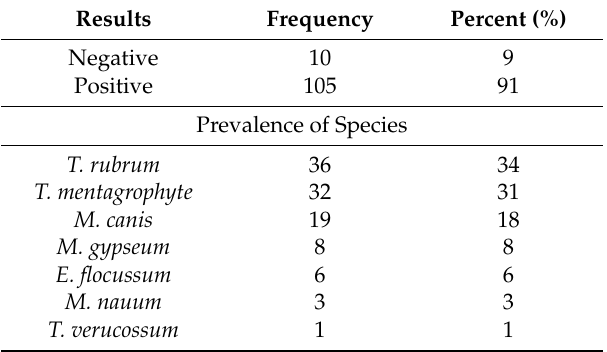
Table 2. Prevalence of tinea capitis among pupils with clinical